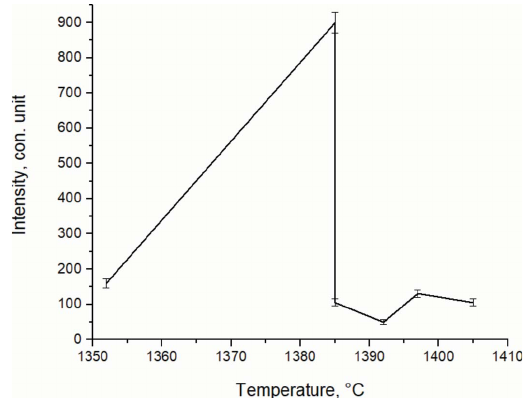
Figure 16 In situ variation in the main reflections intensity of TiAl (111) with temperature during the annealing